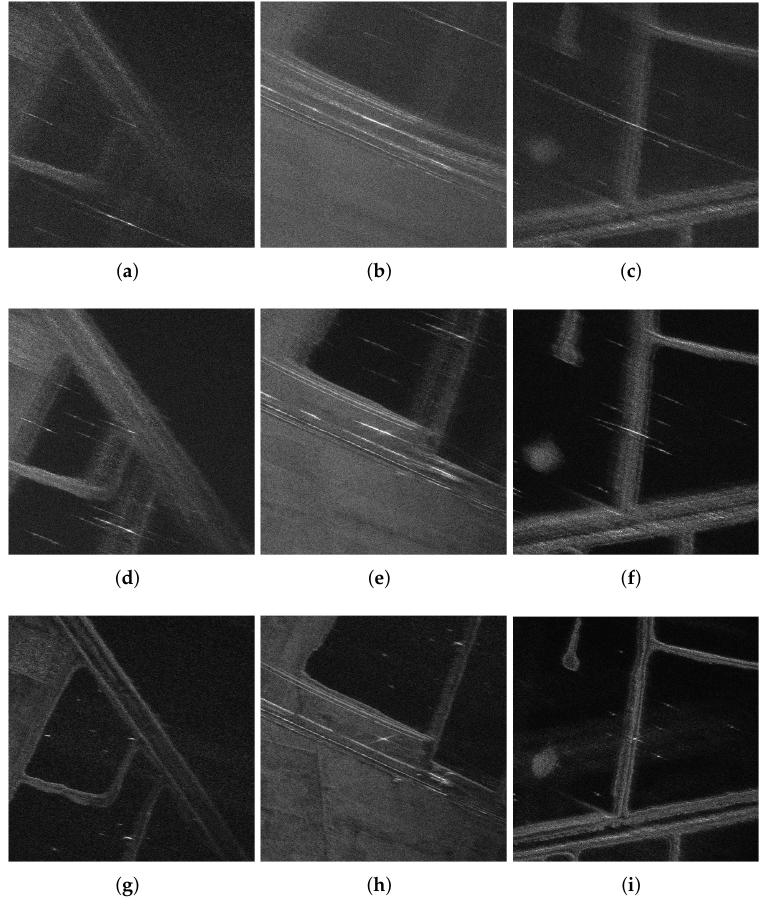
Figure 15. Local images without motion compensation around point ( a ) A, ( b ) B, and ( c ) C. Local images with conventional autofocus around point ( d ) A, ( e ) B, and ( f ) C, and local images with the proposed method around point ( g ) A, ( h ) B, and ( i )